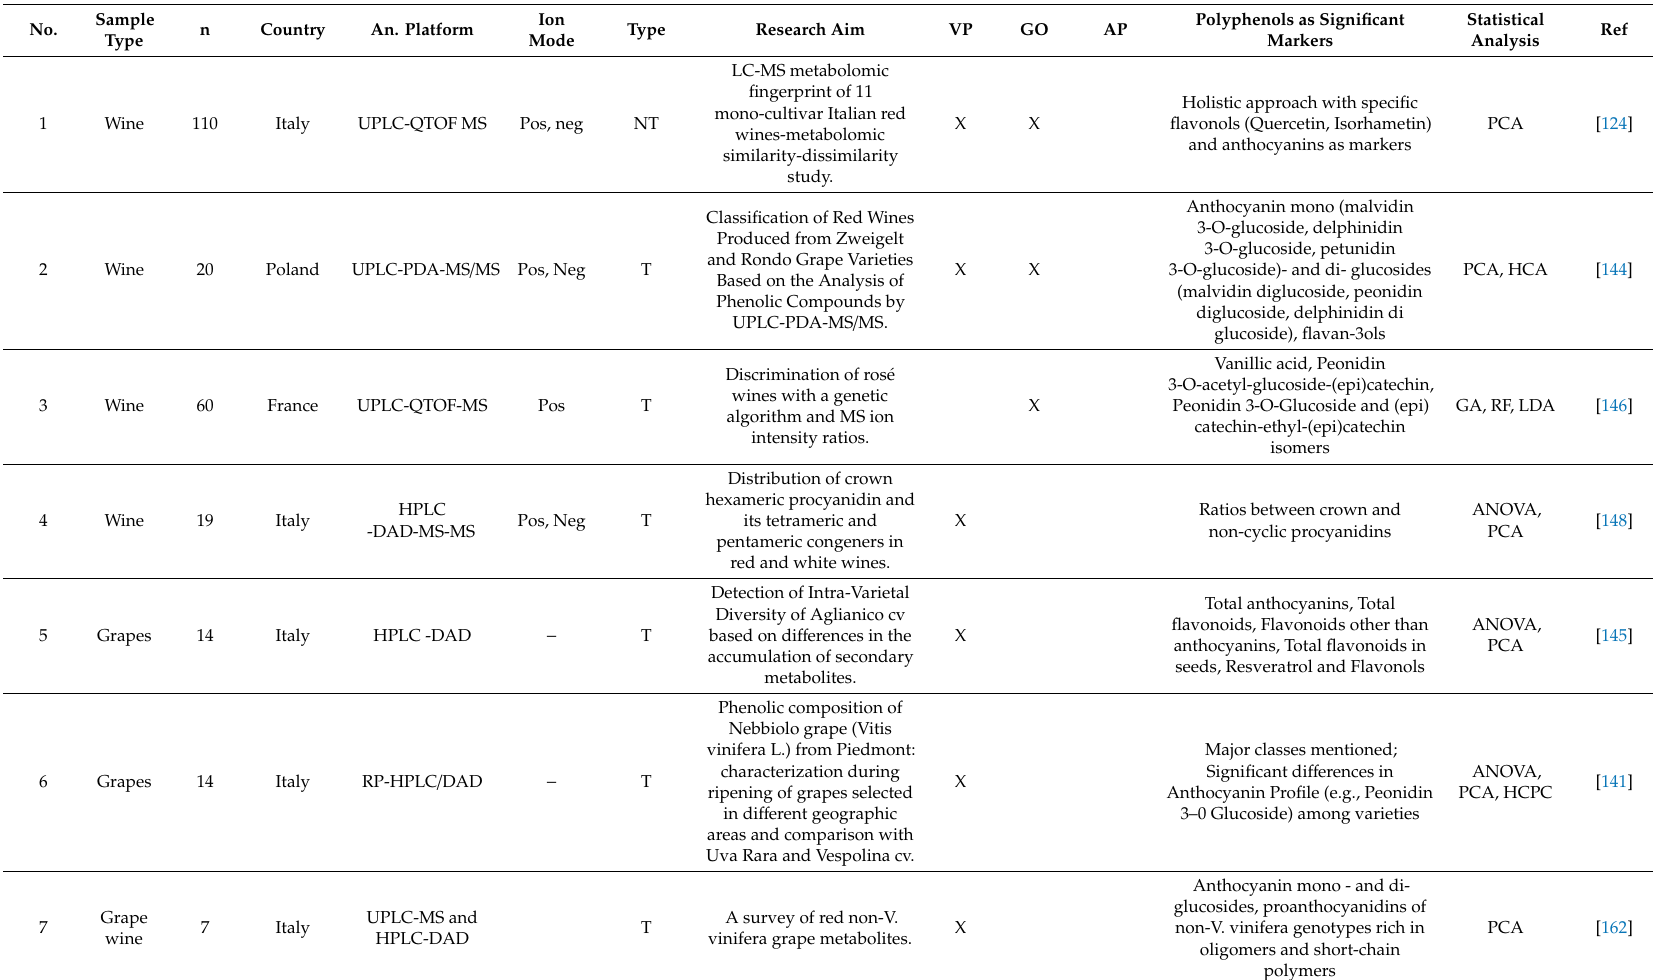
Table 1. Collection of studies involving polyphenols that contribute to wine authenticity